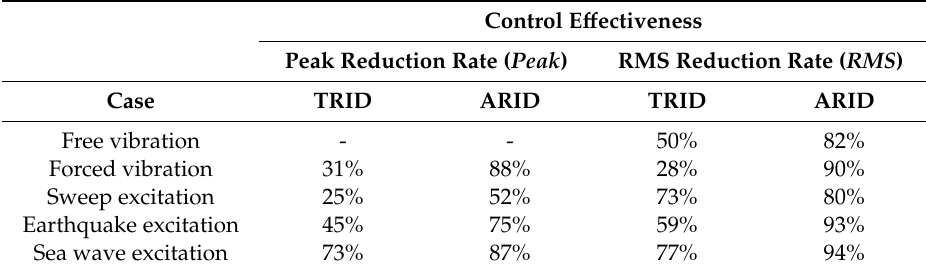
Table 3. Control e ff ectiveness comparison of the ARID system with the TRID system.